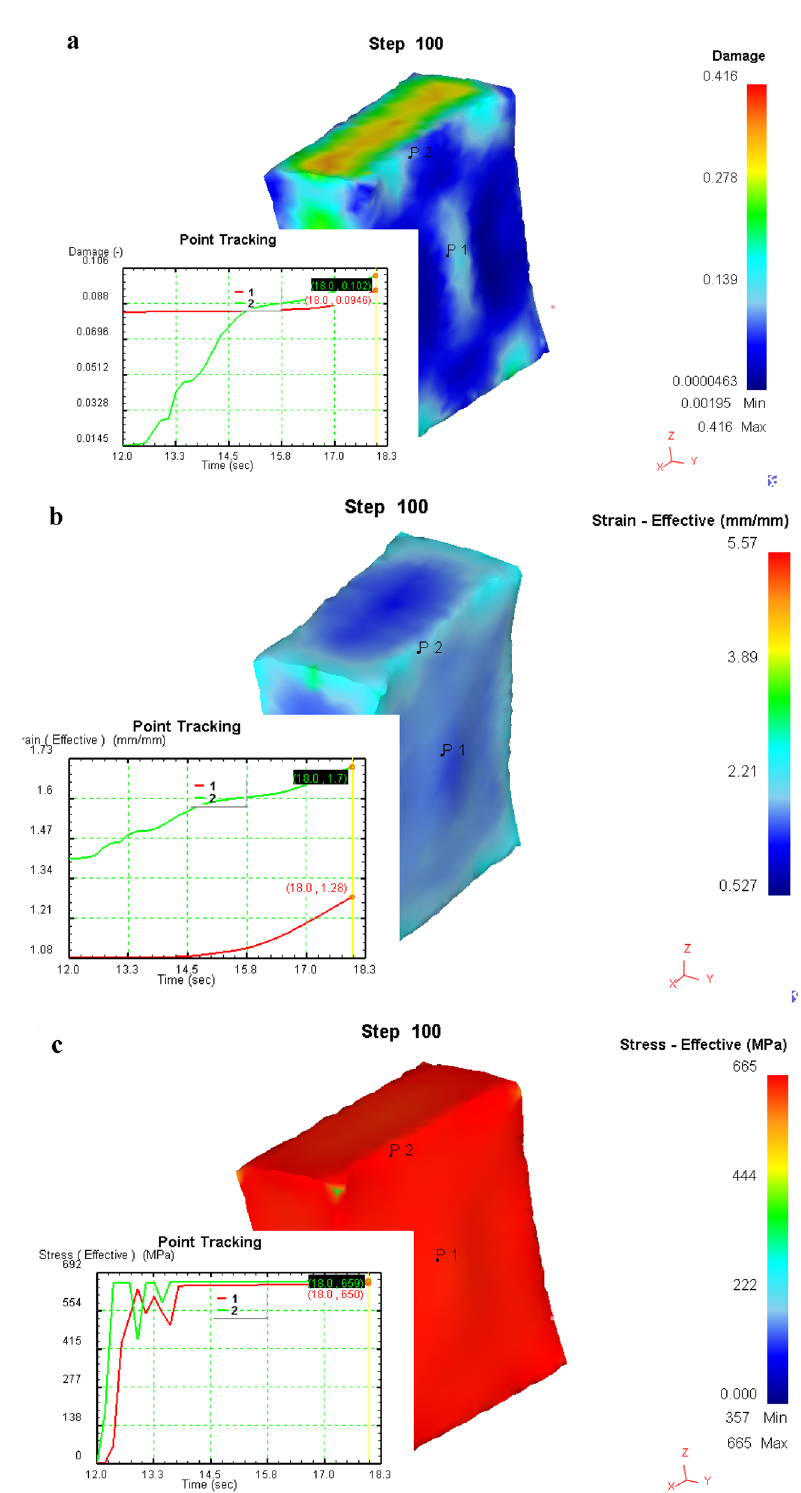
Fig. 6 Results of a damage, b effective strain and c effec- tive stress for a sliced sample, simulated at a temperature of 200 °C, friction coefficient of 0.4, strain per pass of 0.6 and plunger speed of 5